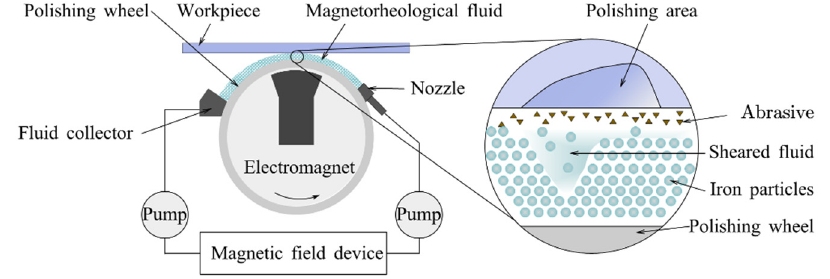
Figure 29. The schematic diagram of MRF [203].